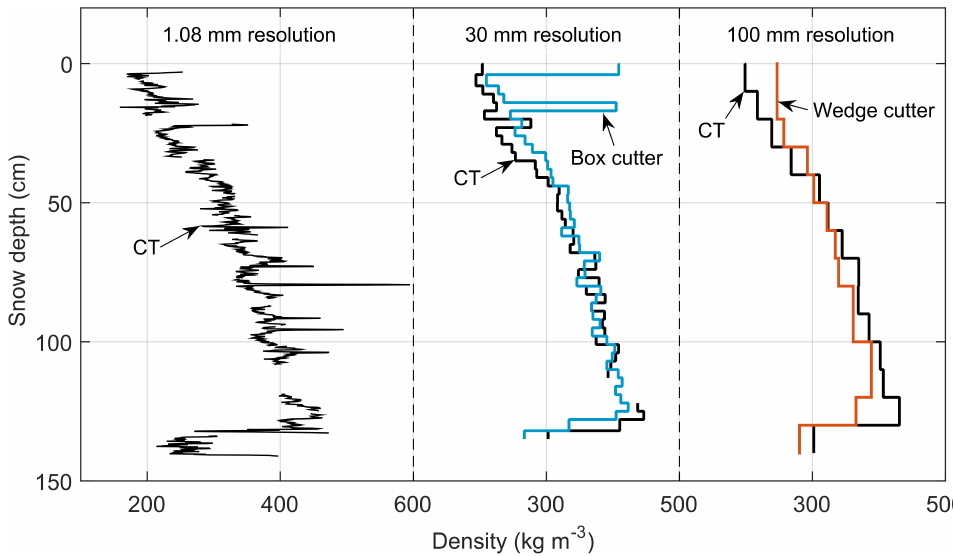
Figure 6. µ CT-derived density (black), subsequently averaged to 30mm (black, middle) and 100mm (black, right) vertical resolution. For comparison, the box cutter densities are shown in raw resolution (turquoise, middle) and averaged to 100mm resolution (brown, right).